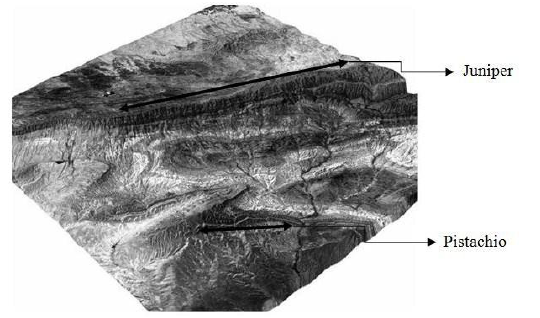
Figure 2. Locations of the study areas in northeast Iran